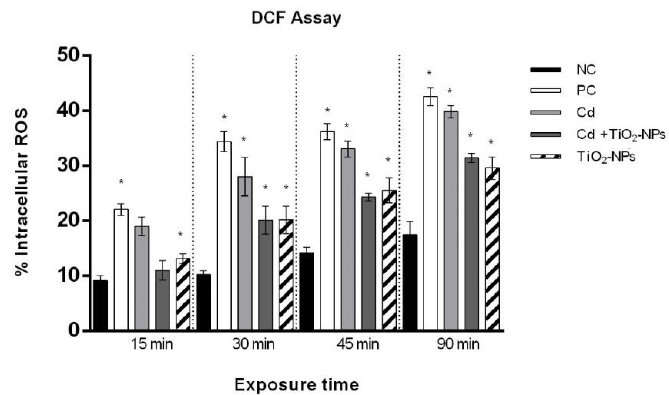
Figure 6. Percentage of intracellular ROS (ordinate) in human sperm after different exposure times (abscissa) to CdCl 2 and CdCl 2 +TiO 2 NPs co-exposure. The black bars are negative controls (NC); the white bars are positive controls (PC) (benzene 0.4 μL/mL); the light grey bars are 10 µM CdCl 2 -treated sperm (Cd); the dark grey bars are 10 µM CdCl 2 + 1 μg/L TiO 2 NPs-treated sperm (Cd + TiO 2 -NPs); the striped bars are 1 μg/L TiO 2 NPs-treated sperm. * p ≤ 0.01.